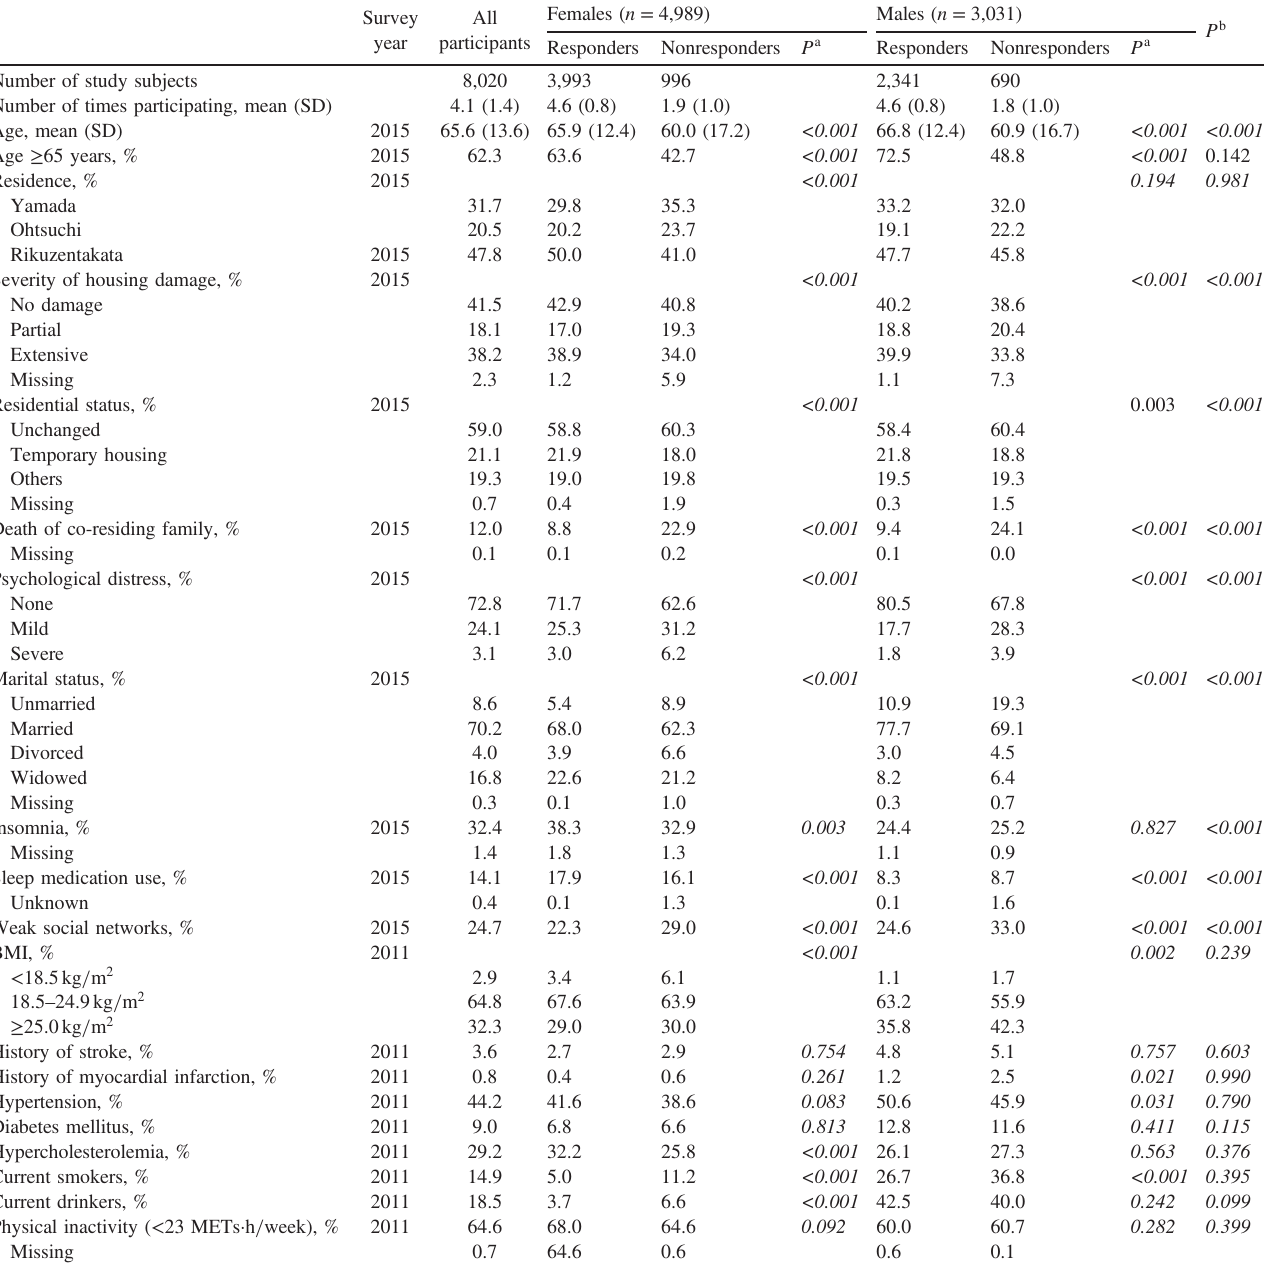
Table 1. Di ff erences in characteristics between responders and nonresponders in the 2015 follow-up survey ( n = 8,020)